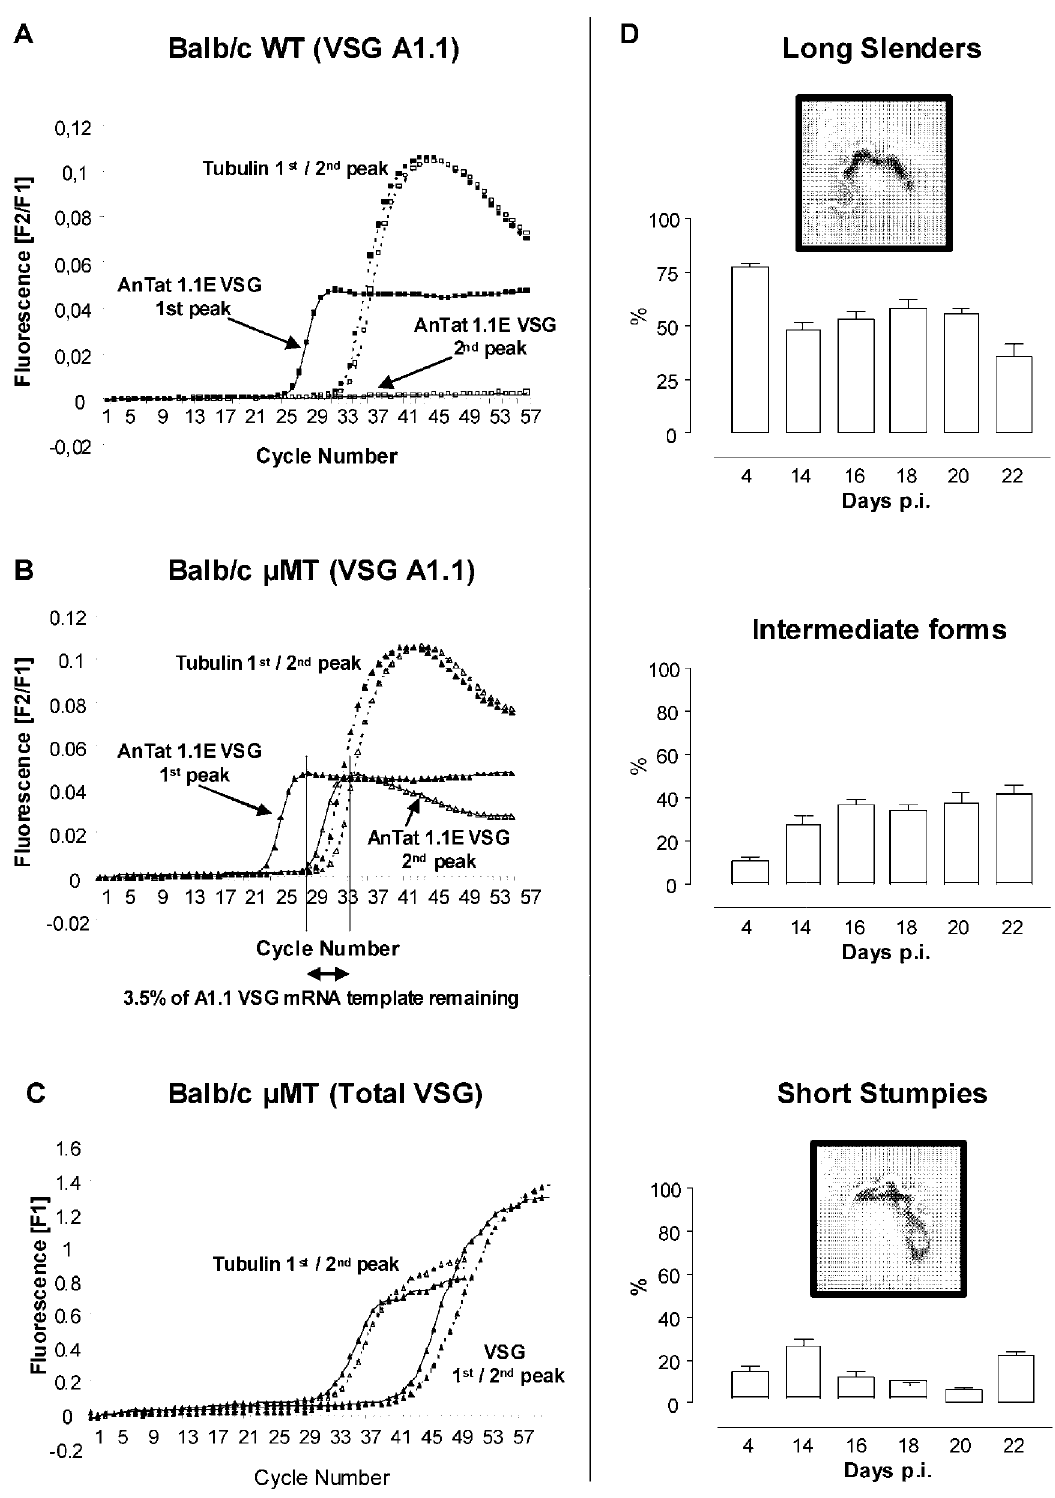
Figure 5. Quantitative analysis of VSG switching. Switching of VSG expression was followed by real time RT-PCR, by amplification of peak stage parasite RNA with primers specific for VSG AnTat 1.1E and the housekeeping genes tubulin-zeta ( Tubulin ). (A) RNA was isolated from WT derived and (B) m MT derived parasites on the first and second peak, respectively occurring on day 6 and 14. Expression of VSG AnTat 1.1E specific RNA on the second peak was calculated and compared to the first peak, after normalization of the first and second peak VSG AnTat 1.1E specific RNA to tubulin- zeta gene expression.. One representative of two experiments are shown. (C) Similarly, total VSG mRNA was amplified from first and second peak m MT derived parasites, using VSG-Uni primers, and results were normalized using Tubulin gene expression. (D) To assess parasite proliferation in m MT mice, the occurrence of dividing ‘long slender’ parasites versus intermediate and non-dividing ‘short stumpy’ parasites was analyzed by light microscopy on day 4 and compared to the chronic infection stage (up to day 22). doi:10.1371/journal.ppat.1000122.g005 PLoS Pathogens |